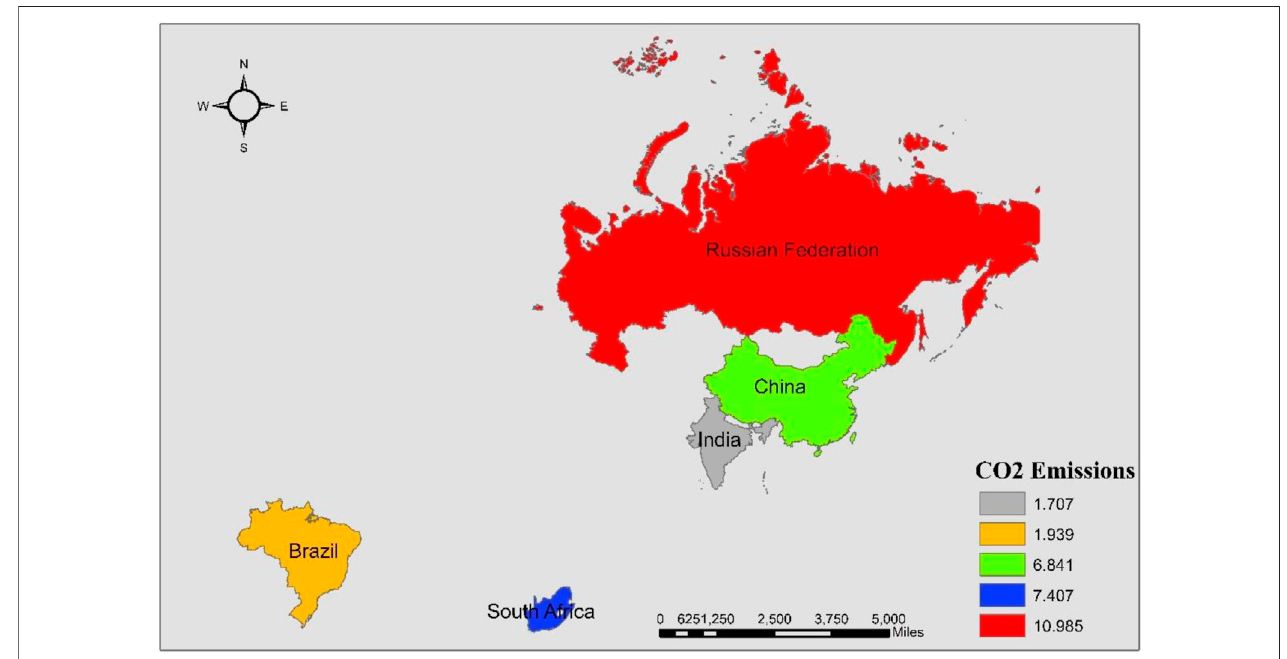
FIGURE 1 | CO 2 emission spatial distributions in BRICS countries for the year 2018. Data Source: IEA (2020).